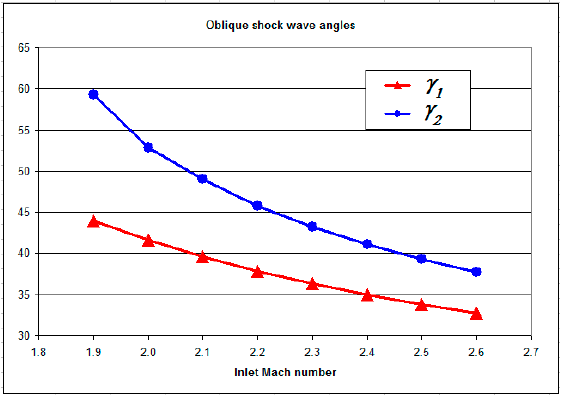
Figure 10. Angles of primary and secondary oblique shockwaves generated by the inlet flow at different Mach numbers.